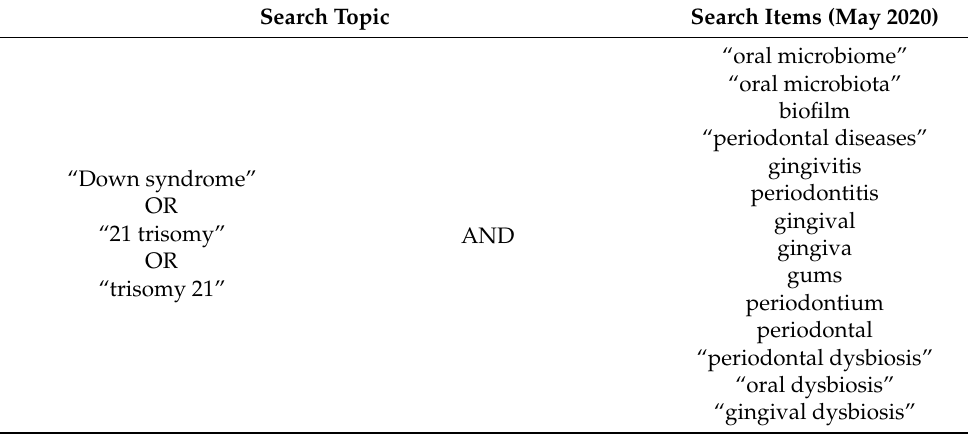
Table 2. The MeSHs terms used in the search and their combinations used by Boolean connectors. Search